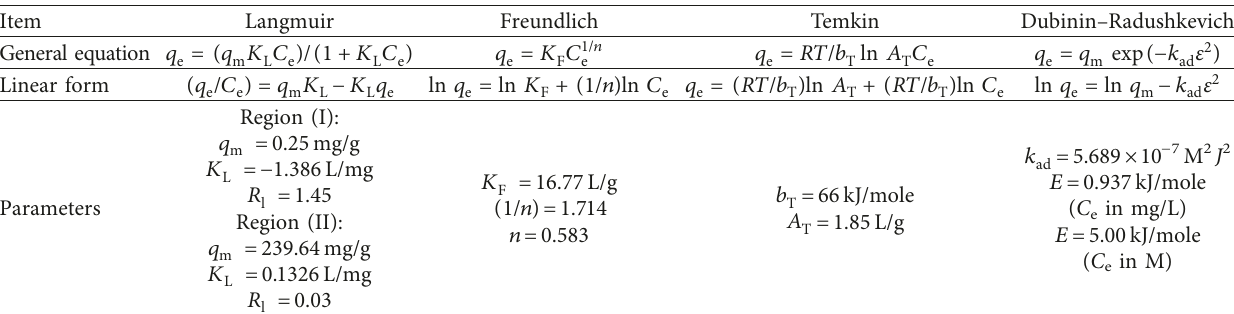
Table 5: General and used linear form equations of the adsorption isotherms with the extracted parameters from Figures 12(a)–12(d) as described [53–55]. Item Langmuir Freundlich Temkin Dubinin–Radushkevich